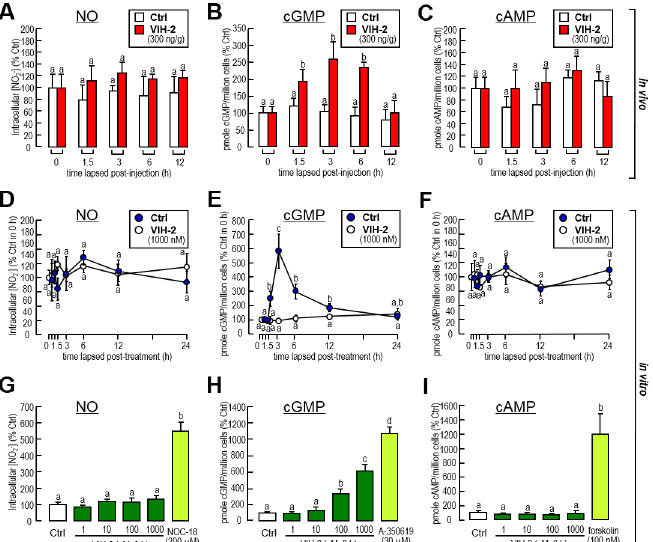
Fig 2. Effects of VIH-2 administration on NO, cGMP and cAMP production in the hepatopancreas of L